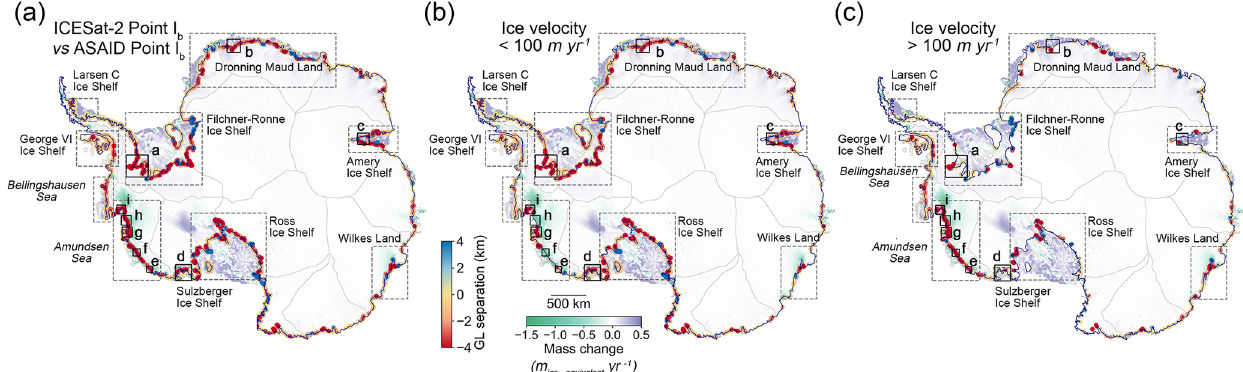
Figure 10. (a) Separations between the ASAID-derived break in slope and ICESat-2-derived break in slope (negative value is retreating while positive value is advancing). (b) Regions with ice velocity (Rignot et al., 2017) less than 100myr − 1 , (c) regions with ice velocity larger than 100myr − 1 . The black boxes denote the spatial extents of regions mapped in Fig. 12. In all subplots, data are superimposed over the recent mass change map (Smith et al., 2020b) and IMBIE basin boundary (Shepherd et al., 2018; Rignot et al., 2011b).